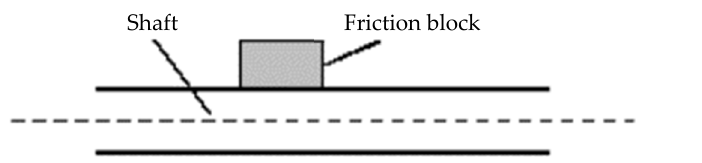
Figure 20. Rotor radial rubbing fault simulation.